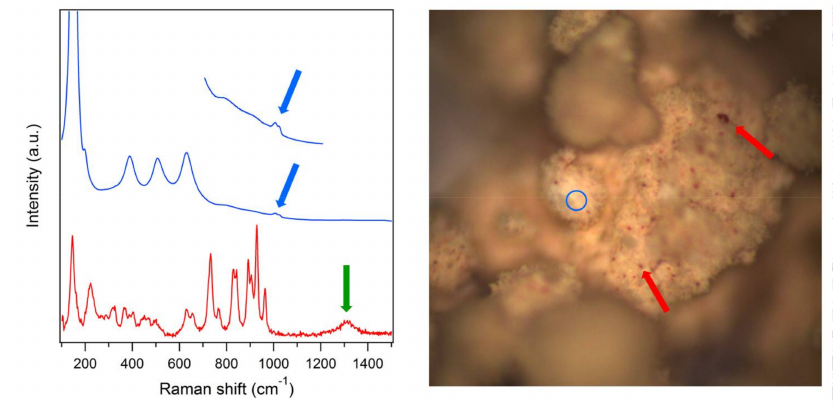
Figure 2. Raman spectra of 8.4 wt % FeVO 4 /TWS (TiO 2 -WO 3 -SiO 2 ). The blue line represents Raman spectrum of a light spot on the sample (blue circle in the optical image) where anatase and surface VO x (blue arrows) were detected; the red line is the spectrum of a red spot (red arrows in the optical image) showing mainly FeVO 4 and a band belonging to Fe 2 O 3 (green arrow in the Raman